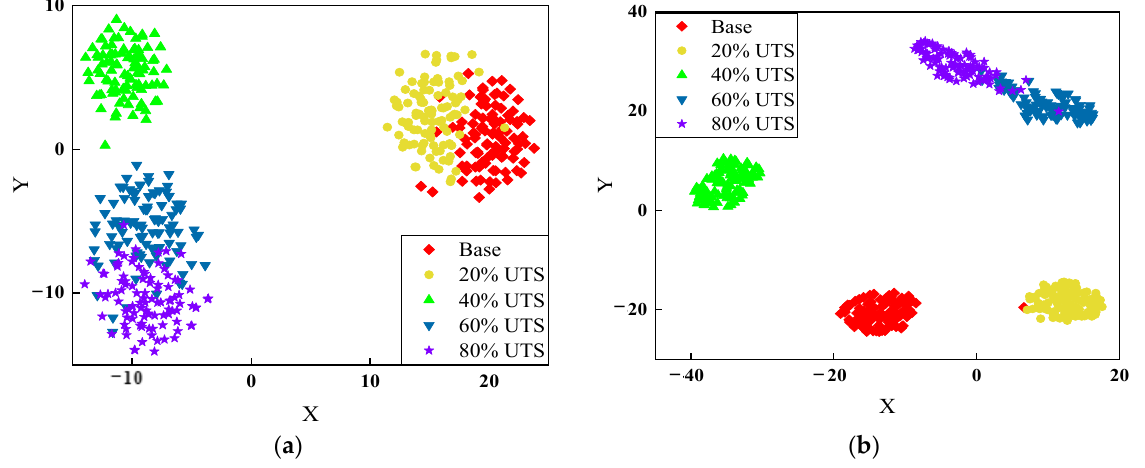
Figure 8. Feature visualization by t -SNE. ( a ) Feature maps in the first convolutional layer; ( b ) feature maps in the last layer.